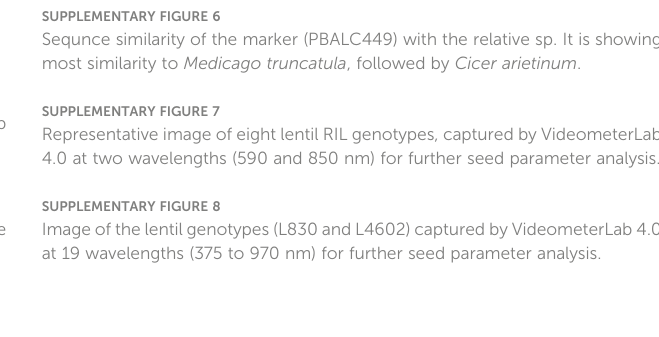
SUPPLEMENTARY FIGURE 3 BLAST for sequence from large seeded parent (L4602) (149 bp). SUPPLEMENTARY FIGURE 4 BLAST for sequence from small seeded parent (L830) (131 bp; due to 18 bp deletion at two places). SUPPLEMENTARY FIGURE 5 Identi fi ed position of the SSR (PBALC 449) in the lentil genome (Chromosome 3).